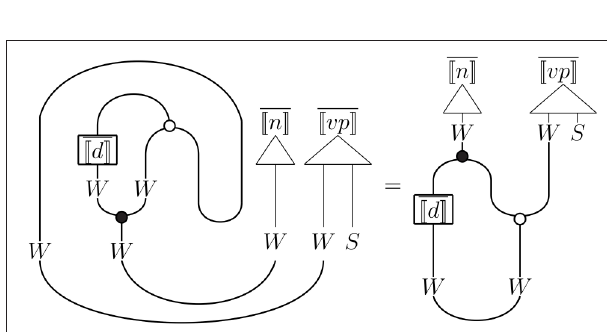
FIGURE 5 | Diagram of Information Flow in a Sentence with a Quantified Subject, cited from Hedges and Sadrzadeh [ 38].